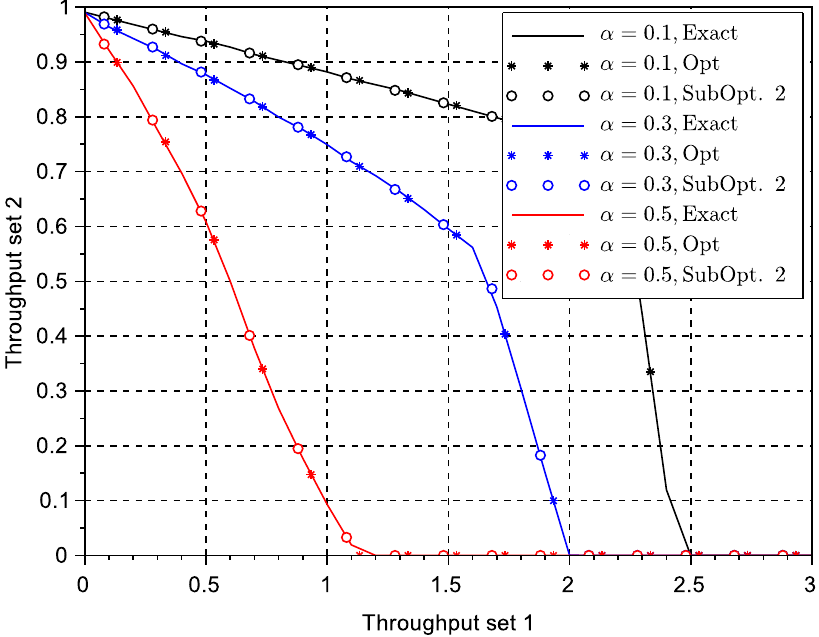
Figure 6. Throughput region of a multi-packet reception (MPR) system with two subsets of terminals: J 1 = 3 and J 2 = 1 using the general reception model with different values of the reception parameter α